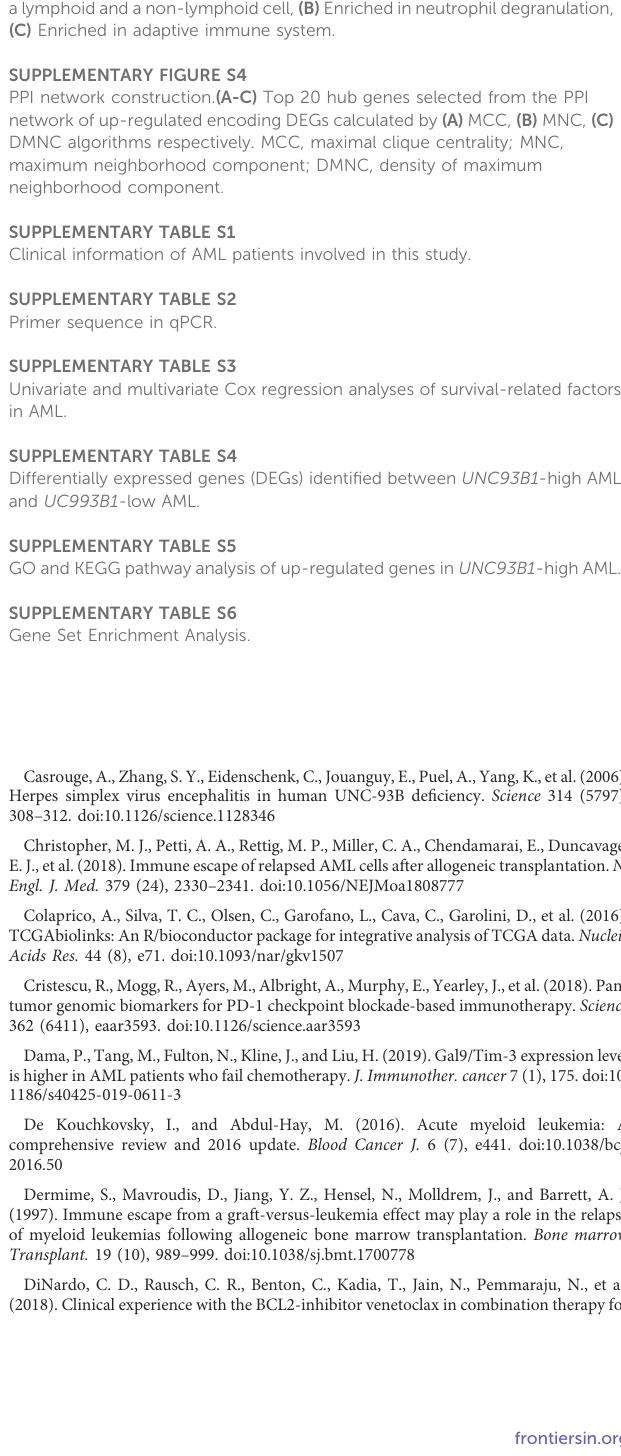
SUPPLEMENTARY FIGURE S1 Association of UNC93B1 expressionand clinicalcharacteristics. (A) Highlevel of UNC93B1 in non-M3 leukemia compared to M3 leukemia according to French-American-British (FAB) classi fi cation. (B) Differential expression of UNC93B1 according to cytogenetics. ns: p ≥ 0.05, * p < 0.05, ** p < 0.01, *** p < 0.001. SUPPLEMENTARY FIGURE S2 Survival analysis of UNC93B1 in different subgroups based on clinical characteristics. (A) AML patients without FLT3 mutation. (B – D) AML patients without IDH1 mutation. (E) AML patients with FLT3 mutation. (F) AML patients with IDH1 R132 mutation. (G) AML patients with IDH1 R140 mutation. (H) AML patients without RAS mutation. (I) AML patients with BM blasts (%) ≤ 20%. (J) AML patients with BM blasts (%) > 20%. (K) AML patients without NPM1 mutation. (L) AML patients with NPM1 mutation. SUPPLEMENTARY FIGURE S3 GSEA analysis of DEGs. (A) Enriched in immunoregulatory interactions between a lymphoid and a non-lymphoid cell, (B) Enriched in neutrophil degranulation, (C) Enriched in adaptive immune system. SUPPLEMENTARY FIGURE S4 PPI network construction. (A-C) Top 20 hub genes selected from the PPI network of up-regulated encoding DEGs calculated by (A) MCC, (B) MNC, (C) DMNC algorithms respectively. MCC, maximal clique centrality; MNC, maximum neighborhood component; DMNC, density of maximum neighborhood component. SUPPLEMENTARY TABLE S1 Clinical information of AML patients involved in this study. SUPPLEMENTARY TABLE S2 Primer sequence in qPCR. SUPPLEMENTARY TABLE S3 Univariate and multivariate Cox regression analyses of survival-related factors in AML.